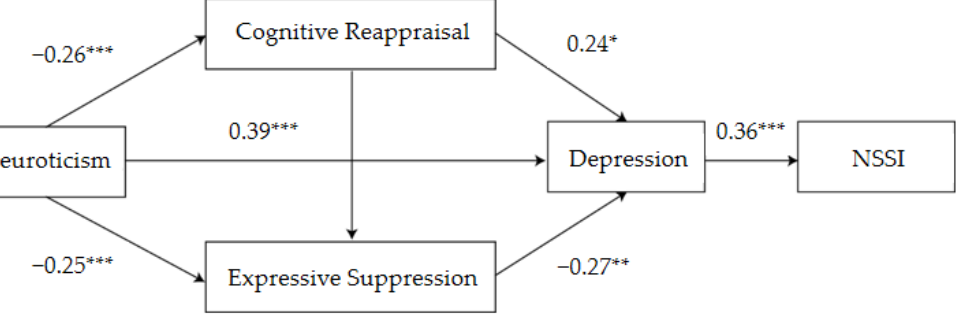
Figure 3. Influence of neuroticism on NSSI behavior: schematic diagram of the mediating role of emotion regulation and depression among female college students. * p < 0.05, ** p < 0.01, *** p < 0.001.